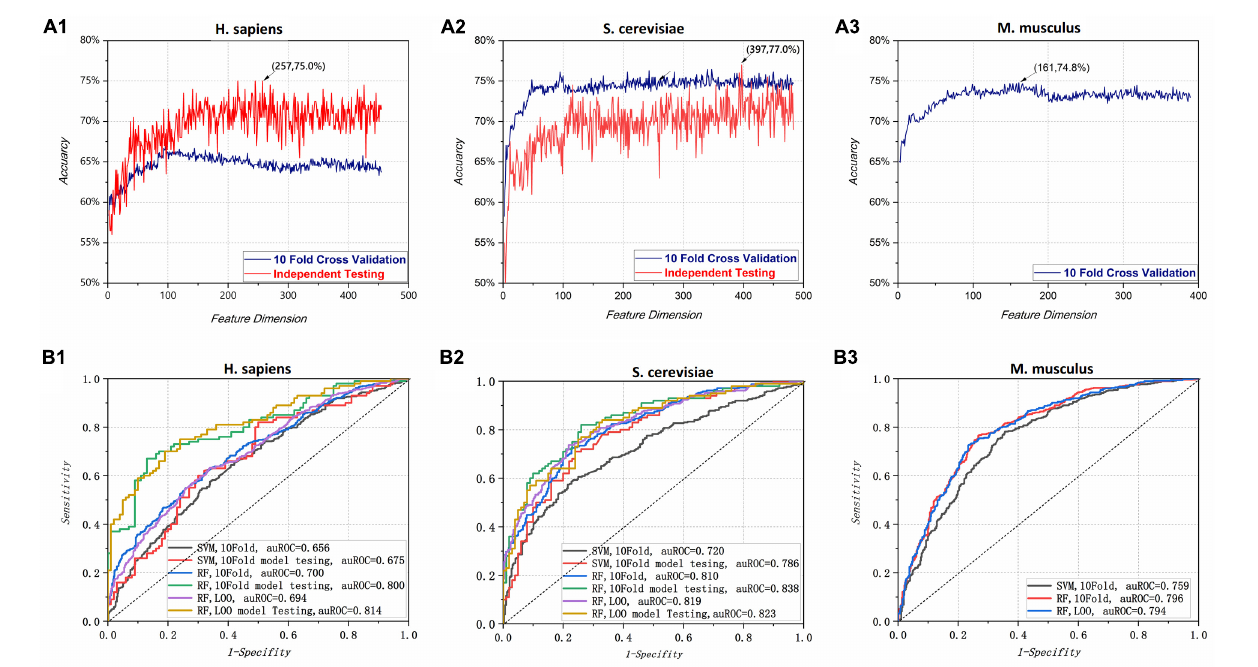
FIGURE 2 | (A) Accuracy of the random forest predictor varied with feature dimension for all three species: (A1) H. sapiens ; (A2) S. cerevisiae ; (A3) M. musculus . The best independent accuracies for H. sapiens and S. cerevisiae were 75.0% with 257 features and 77.0% with 397 features, respectively, and the best 10-Fold cross-validated accuracy for M. musculus was 74.8% with 161 features. (B) Receiver operating characteristic curve (ROC) and area under the ROC curve (auROC) for different species under various conditions. (B1) is for H. sapiens , (B2) is for S. cerevisiae and (B3) is M. musculus . A support vector machine (SVM) was used for comparison with the random forest (RF) model. 10-Fold (10-Fold) model testing and leave-one-out (LOO) model testing indicate the model with the best 10-Fold and LOO cross-validation scores in independent testing. In cross-validation (10-Fold and LOO) and testing process, the training datasets have divided into training part and validation part. That is, they have used the general machine learning evaluation methods (training, validation and testing) for model optimization. In the figure, the 10-fold cross-validation and LOO cross-validation metric values are obtained from the validation part of training part, while the independent testing metric values are obtained from the independent testing